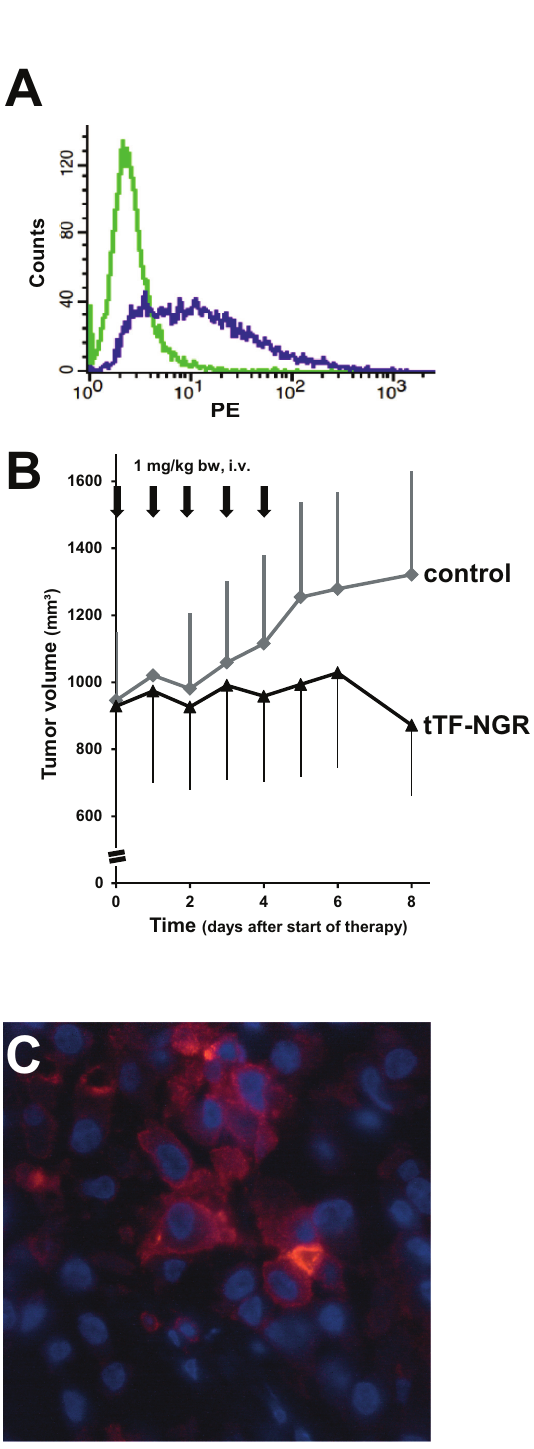
Fig 3. In vivo therapeutic activity of systemic tTF-NGR against CD13+ A549 tumor xenografts. To investigateCD13expressionflow cytometry was performed with a monoclonal PE-labeled anti-CD13 antibody. CD13 expressionwas found in 47% of the A549 lung cancer cells (green, control; purple, CD13) (Fig 3A). Followingtreatment with tTF-NGR (1 mg tTF-NGR/kg x5 (arrows); i.v.; n = 4 CD-1 nudemice) tumor growth of subcutaneous A549 xenotransplants was reducedas comparedto the saline control group (n = 6) CD-1 nude mice (Fig 3B). The CD13expressionin subcutaneous A549 xenotransplant is demonstrated by immunofluorescence; since the antibodiesused for CD13 and CD31 stainingare speciesspecific for human CD13 and CD31, vascular and perivascular staining were not assayed in the xenografts (Fig 3C).